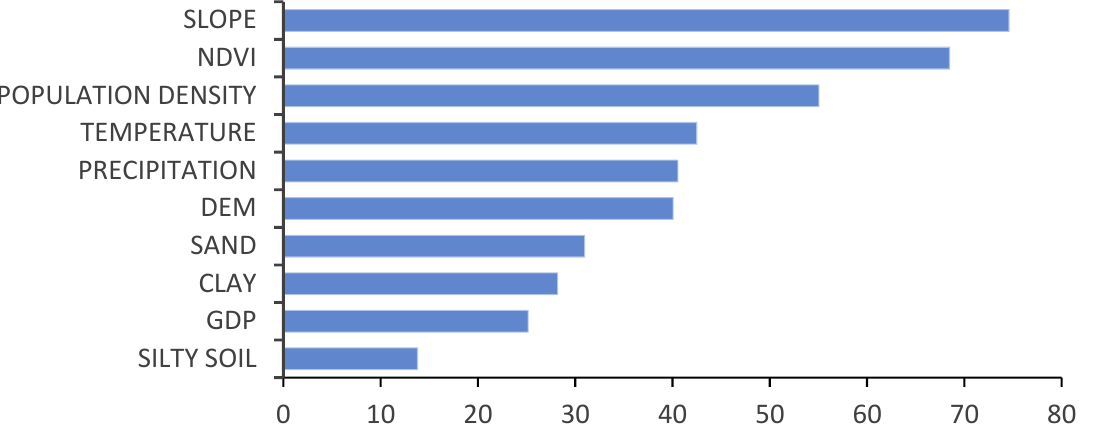
Figure 2. Ranking of the importance of driving factors.